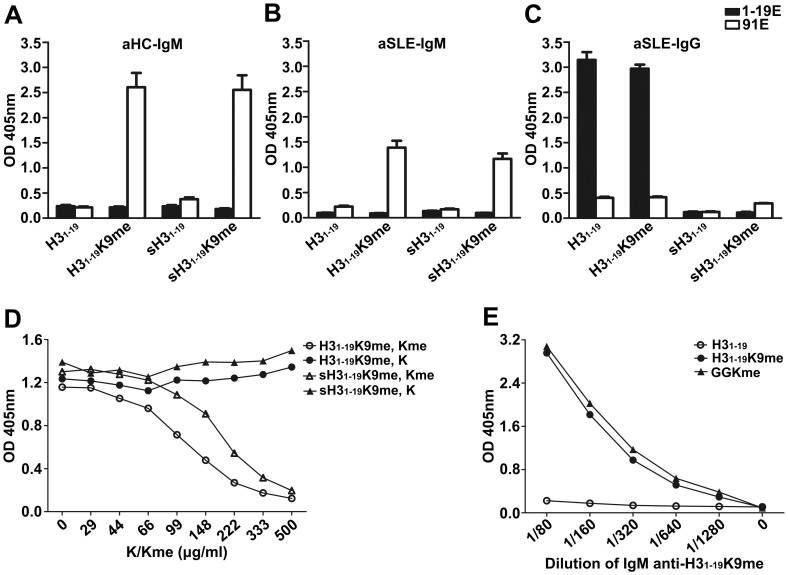
Epitope analysis for IgG and IgM purified from the H31–19 or H31–19K9me beads.(A), (B) and (C) Microtiter plates were coated with H31–19, H31–19K9me, scrambled H31–19 (sH31–19) and scrambled H31–19K9me (sH31–19K9me) conjugated to BSA. IgM of healthy adults from the IgG(1–19low91low)IgM(1–19high91high) subgroup, IgM of aSLE patients from the IgG(1–19low91low)IgM(1–19high91high) subgroup and IgG of aSLE patients from the IgG(1–19high91x)IgM(1–19x91x) subgroup were tested. KT16 anti-human IgM mAb and KT47 anti-human IgG were used as the primary Abs. HRP-conjugated goat anti-mouse IgG was used as the secondary Ab. 1–19E, Abs eluted from the H31–19 beads; 91E, Abs eluted from the H31–19K9me beads. Data are expressed as mean+SEM. (D) Microtiter plates were coated with H31–19K9me or sH31–19K9me conjugated to BSA. IgM Abs of healthy adults from the IgG(1–19low91low)IgM(1–19high91high) subgroup were incubated with lysine (K) or ε-amine mono-methylated lysine (Kme) at indicated concentrations for 1 h at room temperature. KT16 anti-human IgM was used as the primary Ab. HRP-conjugated goat anti-mouse IgG was used as the secondary Ab. (E) Microtiter plates were coated with H31–19, H31–19K9me and GGK(me)GGSGGSGGSG (GGKme) conjugated to BSA. IgM of healthy adults from the IgG(1–19low91low)IgM(1–19high91high) subgroup was tested. KT16 anti-human IgM was used as the primary Ab. HRP-conjugated goat anti-mouse IgG was used as the secondary Ab. The results are representative of three separate experiments.